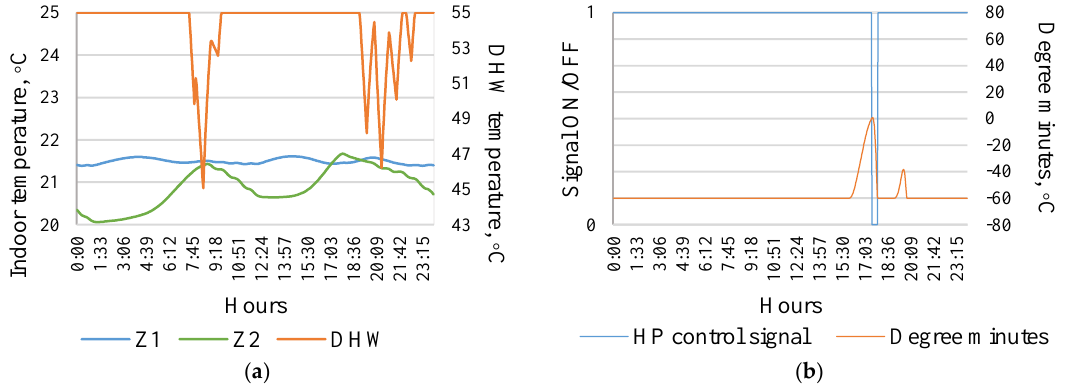
Figure 10. ( a ) Indoor temperature and DHW supply temperature, ( b ) GSHP control and DM value signal for a single-family house occupied by